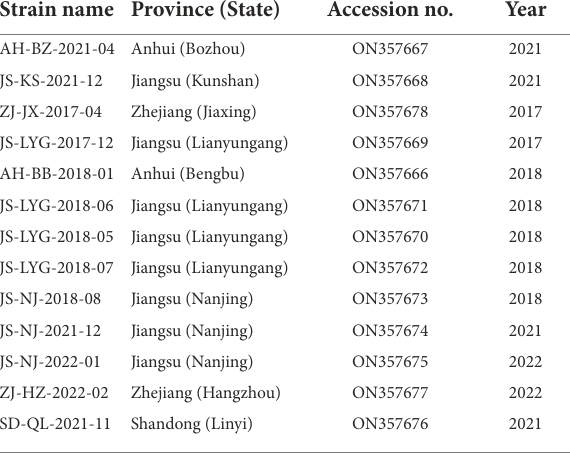
TABLE 2 Information of 13 PRRSV isolates from Eastern China in this study. Strain name Province